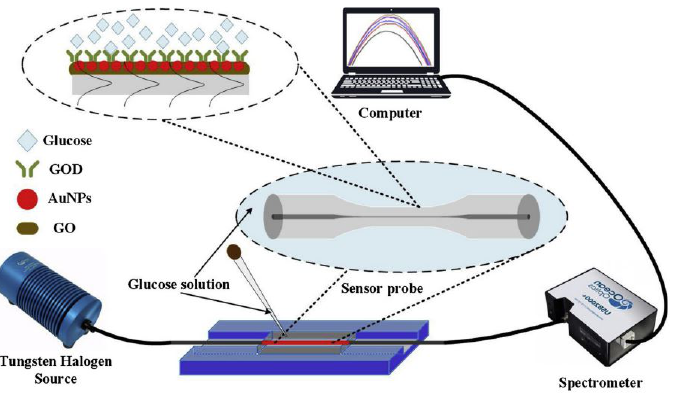
Figure 15. Experimental arrangement of the glucose sensor described in [16].